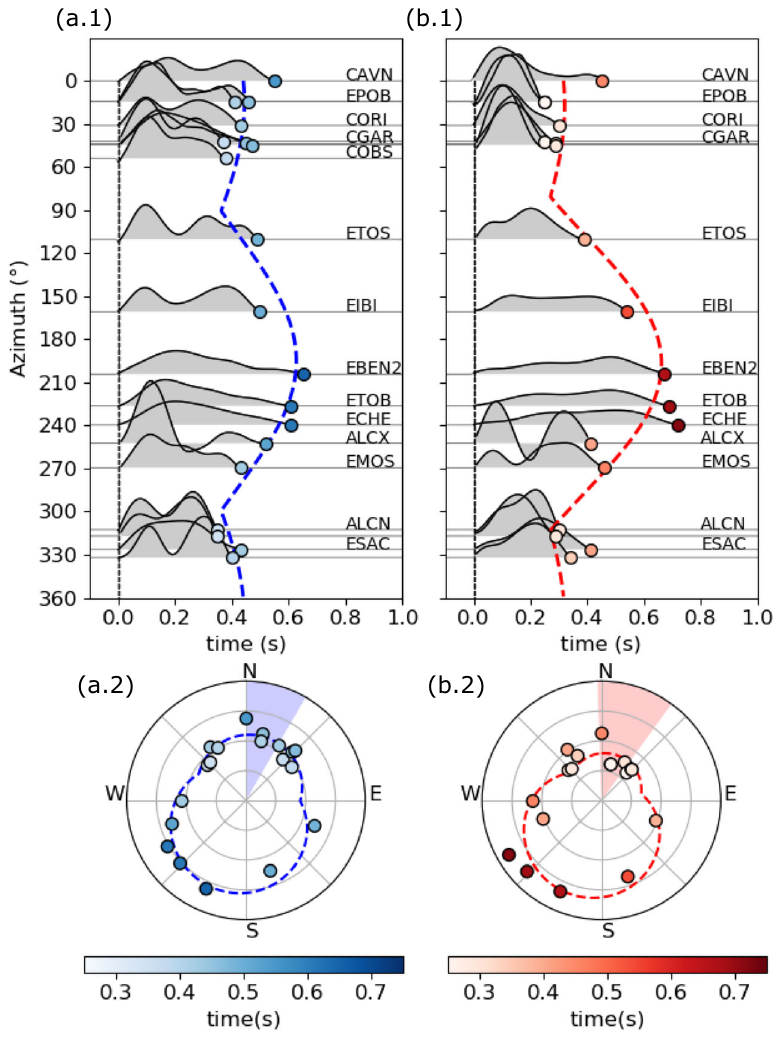
Fig. 5 Rupture directivity inferred for the two largest earthquakes of the sequence. a Mw 4.1 October 1, 2013, 03:32 UTC and b Mw 4.1 October 2, 2013, 23:06 UTC earthquakes at the Castor platform. a.1, b.1. The duration of apparent source time functions are plotted sorted by azimuth, showing apparent durations (circles) and moment rates (gray area) at each station (see labels), and the asymmetric bilateral rupture model from the directivity analysis (dashed lines). a.2, b.2. Apparent durations as in a.1, b.1 (circles) along with the synthetic predictions for the inverted model (dashed lines) show the predominant rupture direction in a polar plot, where apparent source durations are plotted along the radial axis (axis ticks correspond to 0.2 s). The uncertainty in the direction of the rupture direction (range of angles denoted with blue and red areas) are estimated from